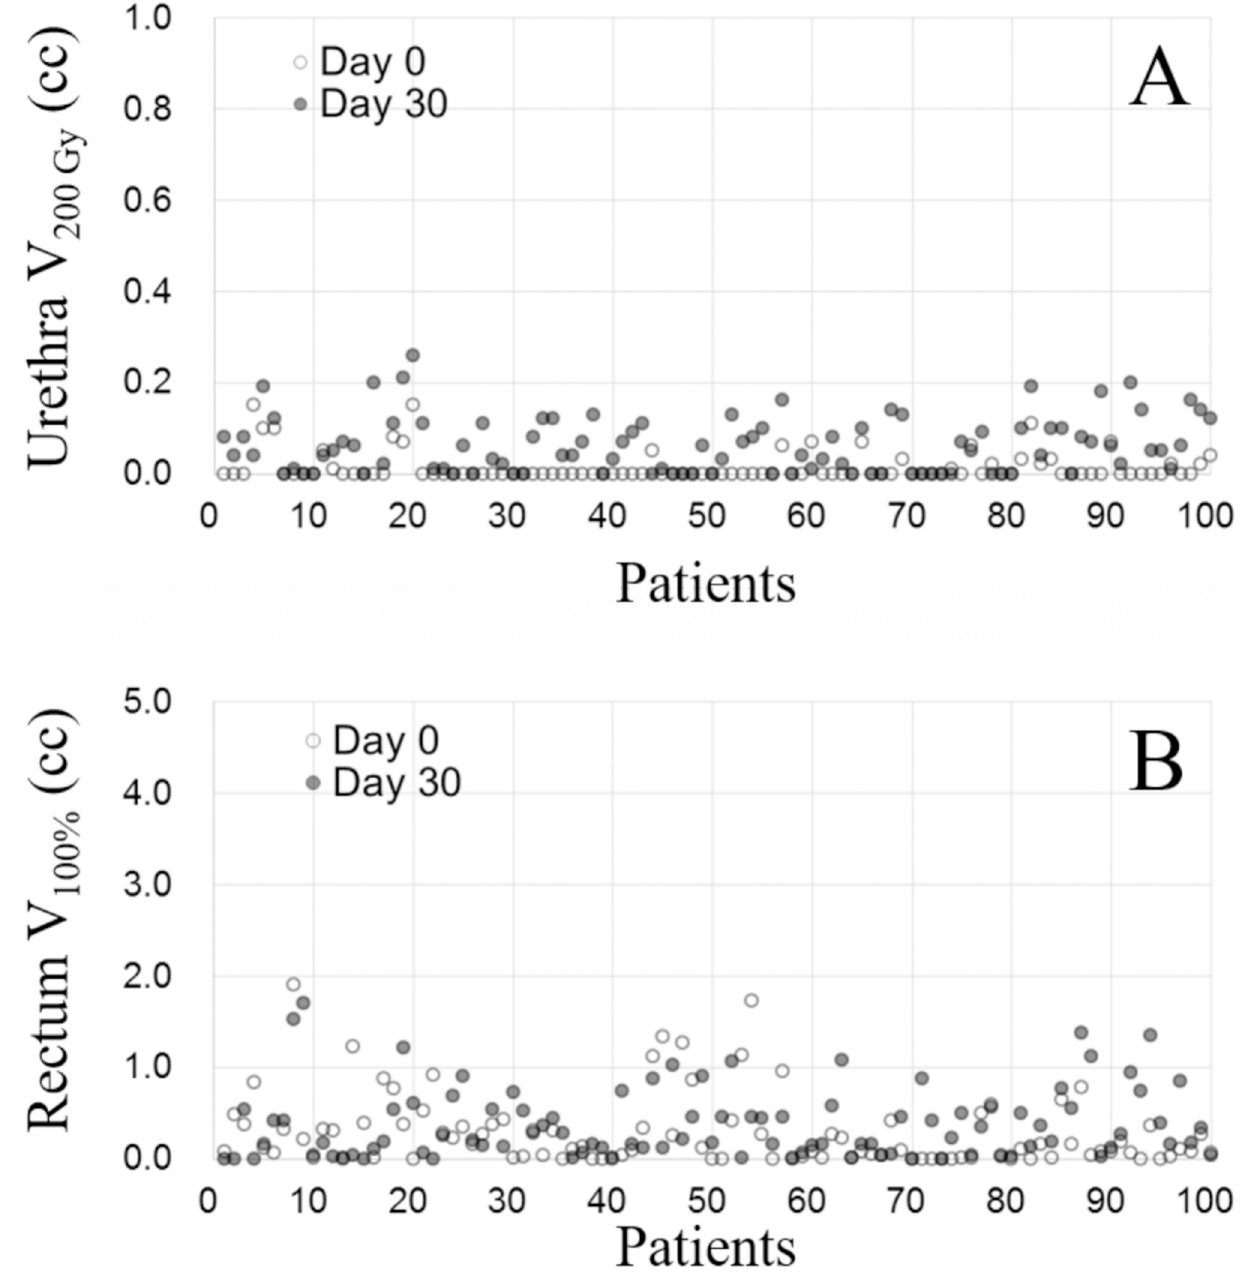
Fig 8. Scatter plots showing (A) the urethra V200 Gy and (B) rectum V100%. The values suggest that the doses to the urethra and rectum were maintained at around or lower than the threshold after implantation. In both plots, light dots indicate the values on day 0 and dark dots indicate the values on day 30. Demonstrably, highly controlled implantation was achieved in all cases without excessive dose to the organs at